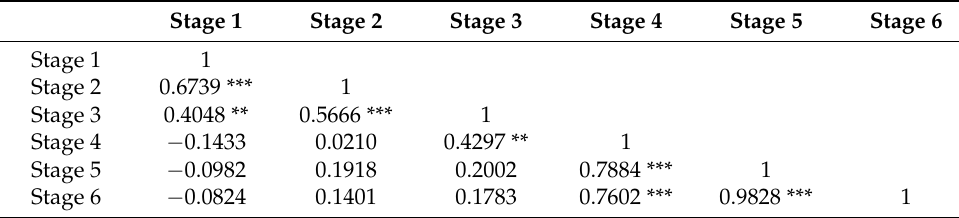
Table 3. Correlations of mitigation efficiency between different